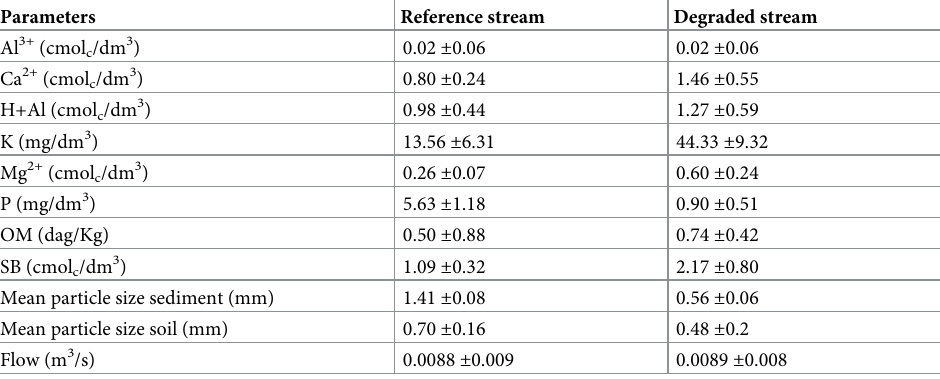
Al 3+ = exchangeable aluminum, Ca 2+ = calcium ions, H.Al = potential acidity, K = potassium, Mg 2+ = magnesium ions, OM = organic matter, P = phosphorus and SB = sum of exchangeable